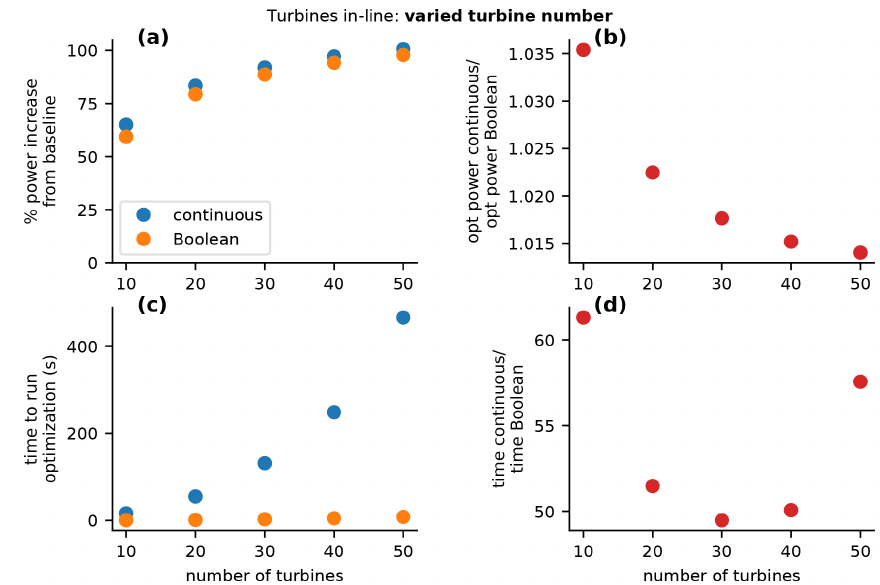
Figure 3. Comparison of a wind plant optimized with a traditional continuous optimization compared to our novel Boolean optimization. The results in this figure are for a single row of turbines in-line with the incoming wind. For the purposes of this figure, the spacing between wind turbines was constant at 5 rotor diameters, while each panel shows different metrics as a function of the total number of wind turbines in the plant. (a) The absolute percent increase in power over the nonyawed baseline for the continuous and Boolean optimizations. (b) The ratio of the optimized power with the continuous approach to the optimized power with the Boolean approach. (c) The absolute time required to run each optimization, again for the continuous and Boolean approaches. (d) The ratio of the time required for the continuous optimization to the time required for the Boolean